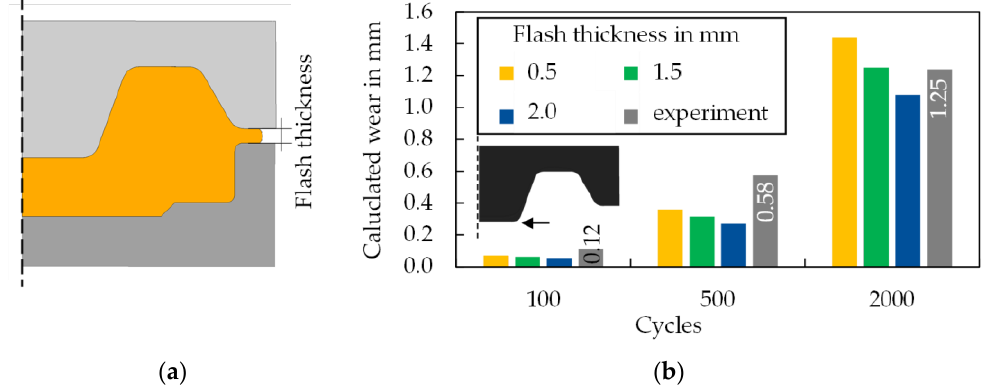
Figure 15. ( a ) Definition of the flash thickness and ( b ) experimental results and numerical wear calculation for die type 1.